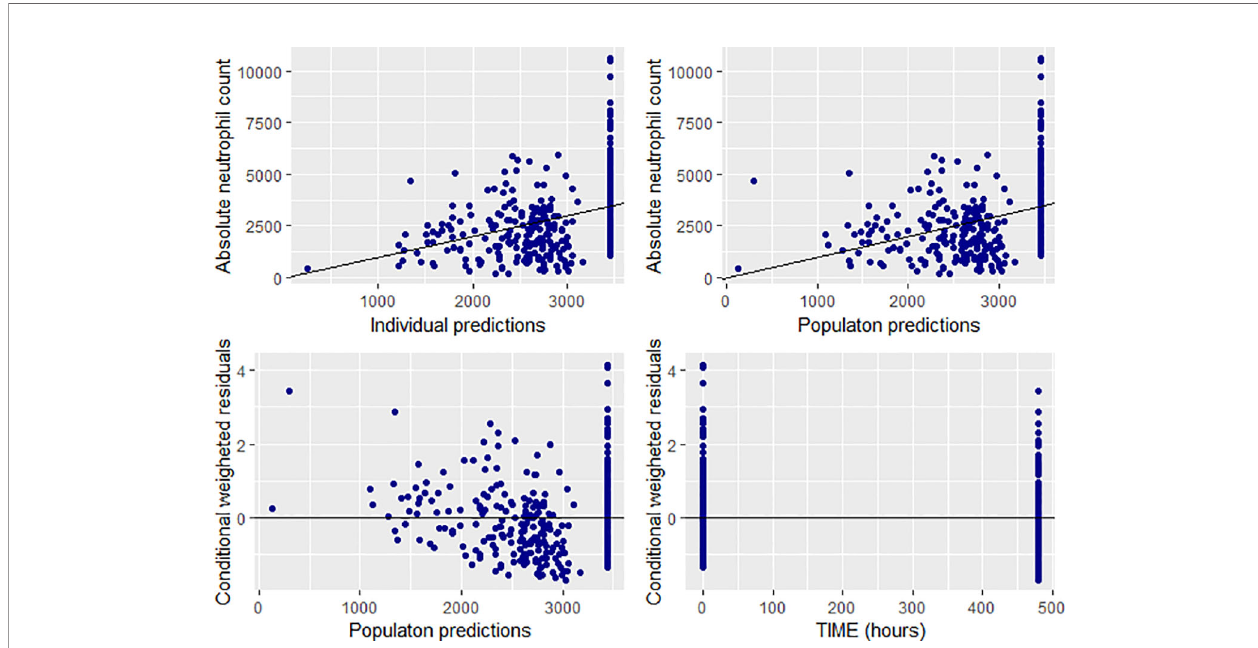
FIGURE 7 | Goodness of fi t plots for the fi nal population PD model (absolute neutrophil count, individual and population predictions were all in 10 3 cells/mm 3